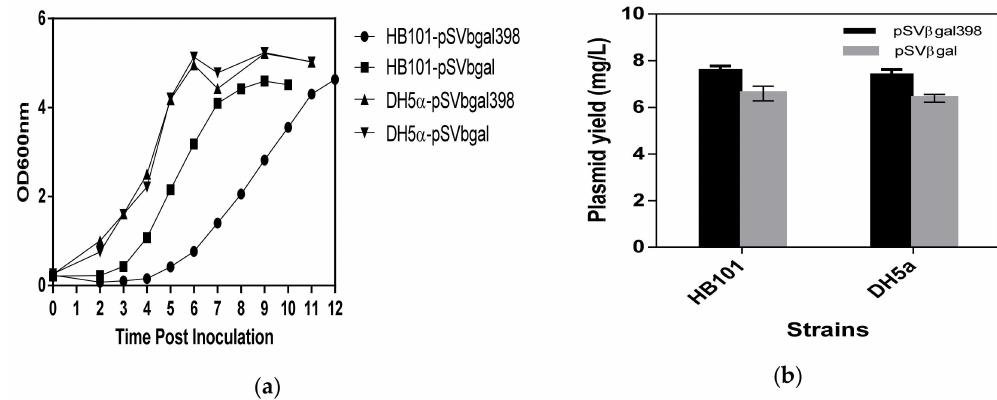
Figure 2. Characteristics of shake flask fermentation of the two strains HB101 and DH5 α . Charts show ( a ) growth curve of the strains bearing both the non-SGS plasmid and SGS containing plasmid and ( b ) plasmid yield of pSV β -gal398 and pSV β -gal amplified in the two strains. Results are the mean of triplicate samples (n =